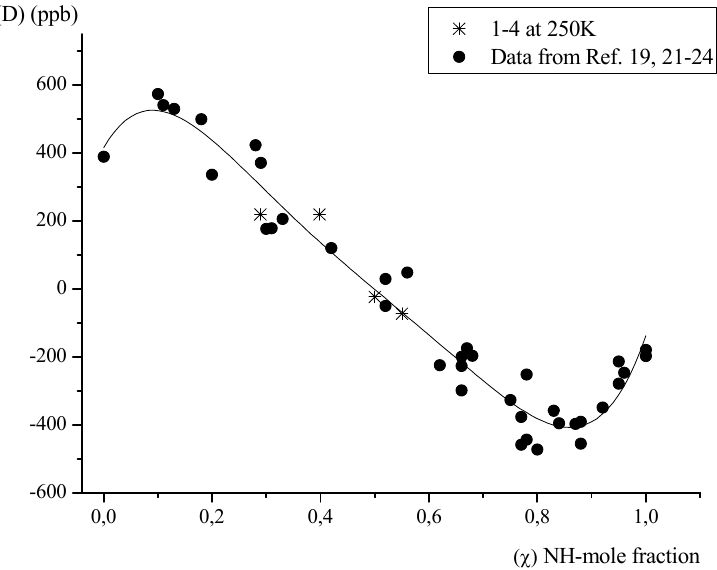
Figure 3. Plot of  C-2(D) vs. mole fraction of the proton transferred NH-form ( 